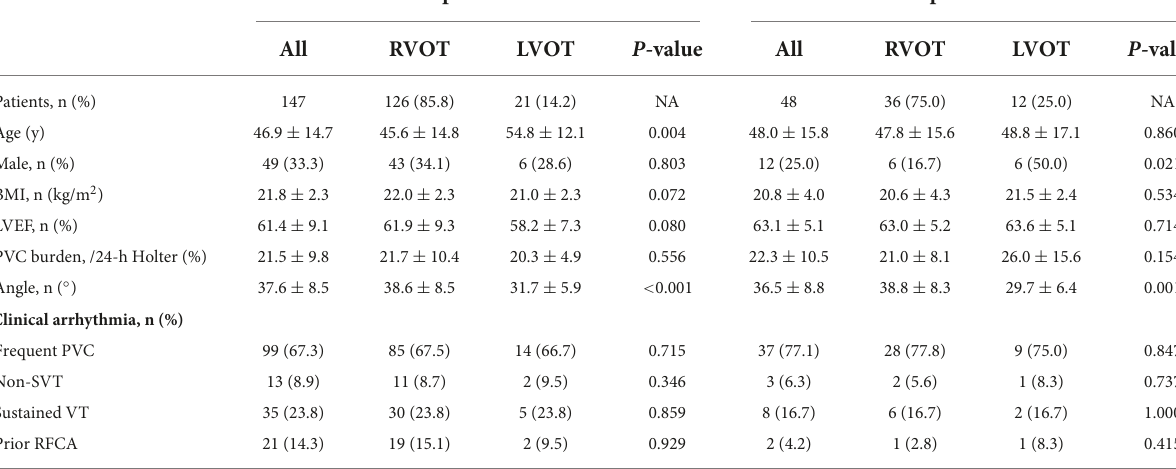
TABLE 1 Baseline characteristics of patients in retrospective and prospective